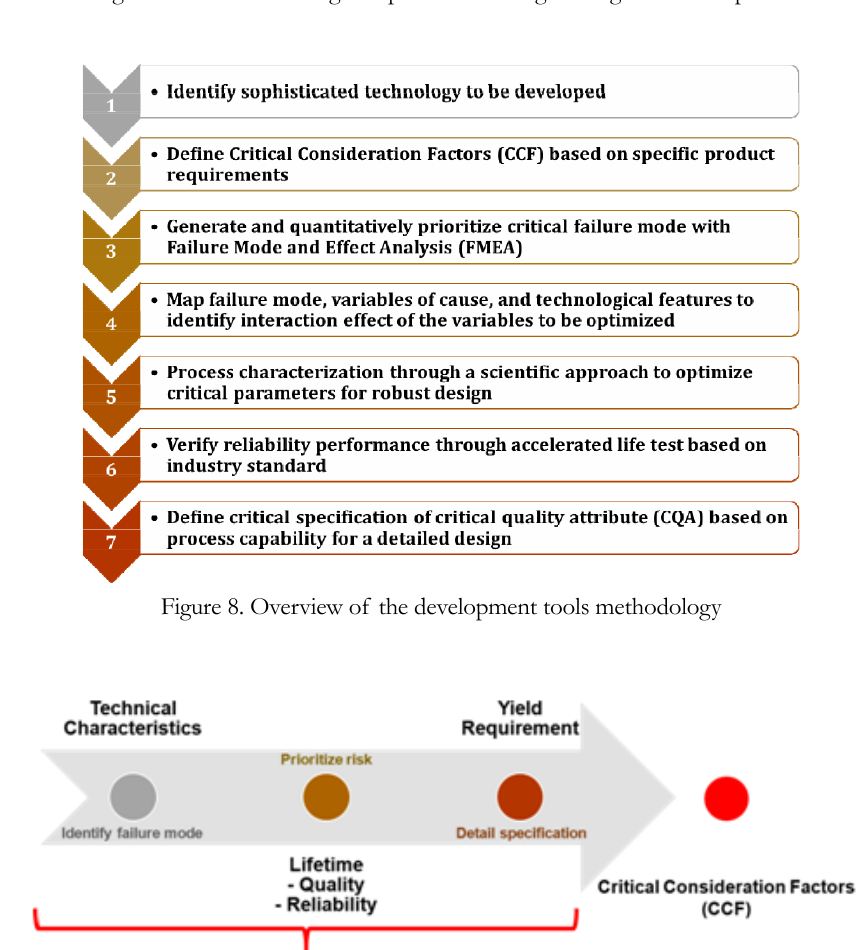
Figure 7. Factors affecting competitive advantage of high-tech enterprises